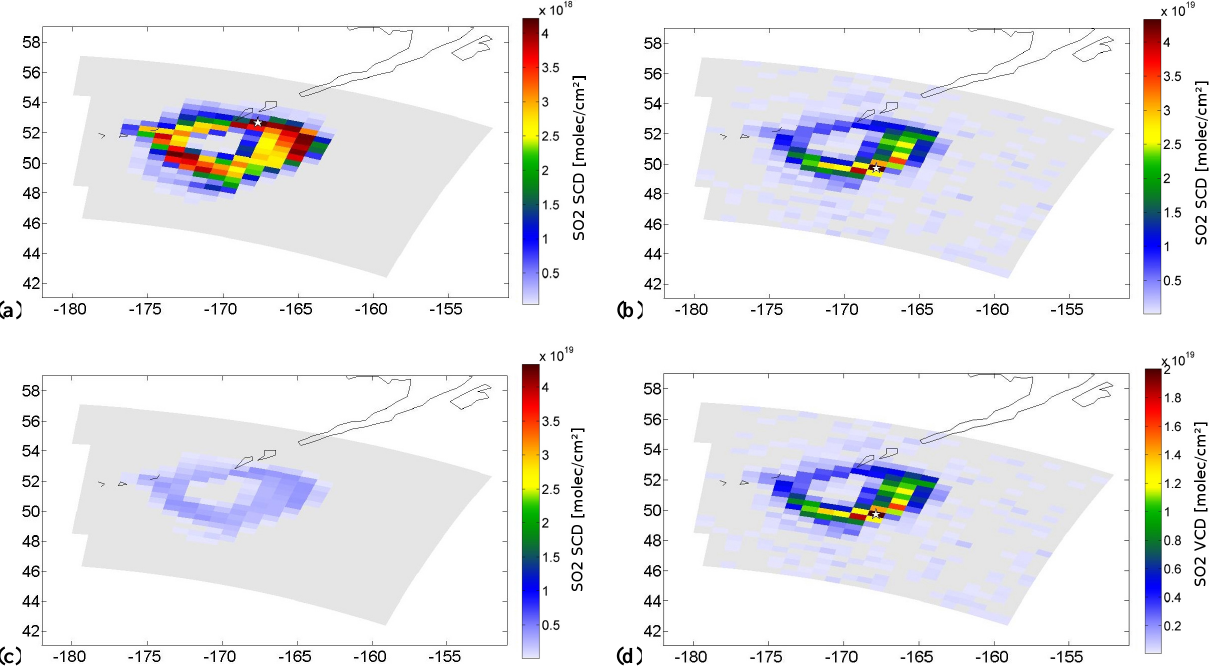
Fig. 3. SO 2 plume after the Kasatochi eruption on 8 August 2008 recorded by GOME-2, The pixels with the maximum column densities are indicated by a white star. (a) evaluation in the short wave UV window 312.1–324nm (max SO 2 SCD ≈ 2 . 2 ± 0 . 3 × 10 18 mol/cm 2 (b) evaluation in the long wave UV window 360–390nm (max SO 2 SCD ≈ 4 . 7 ± 0 . 1 × 10 19 mol/cm 2 ) (c) evaluation in short wave UV window using the same color scale as shown in (b). (d) SO 2 VCDs for the long wave UV window 360–390nm (max SO 2 VCD ≈ 1 . 87 × 10 19 mol/cm 2